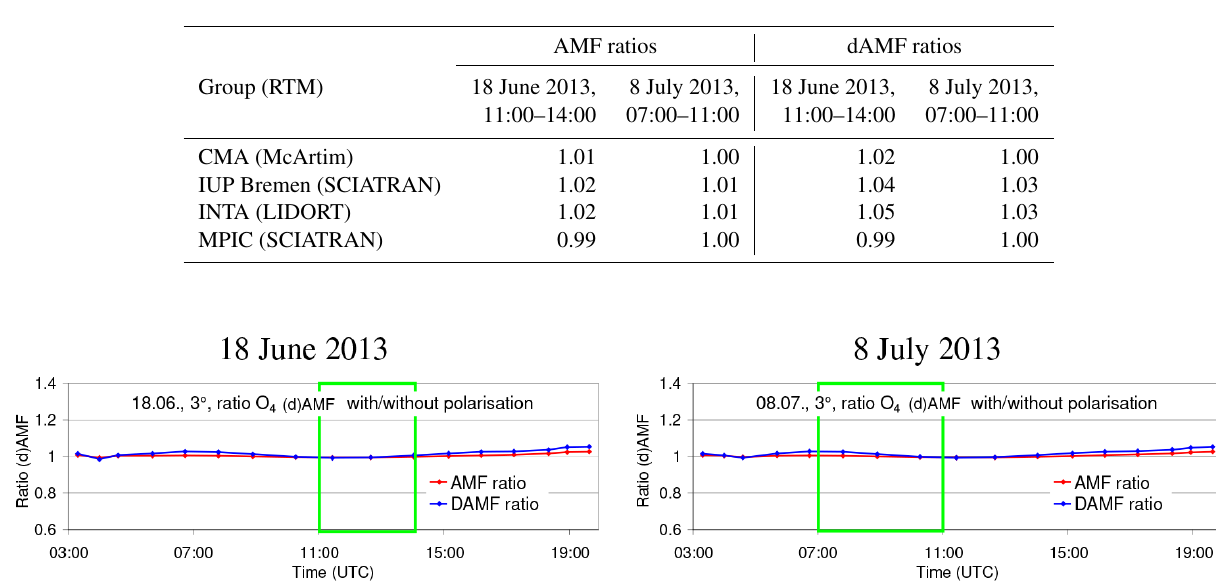
Table A11. Average ratios of O 4 (d)AMFs simulated by different groups using different radiative transfer models vs. those for the MPIC simulations using McArtim for the middle period on each selected day.